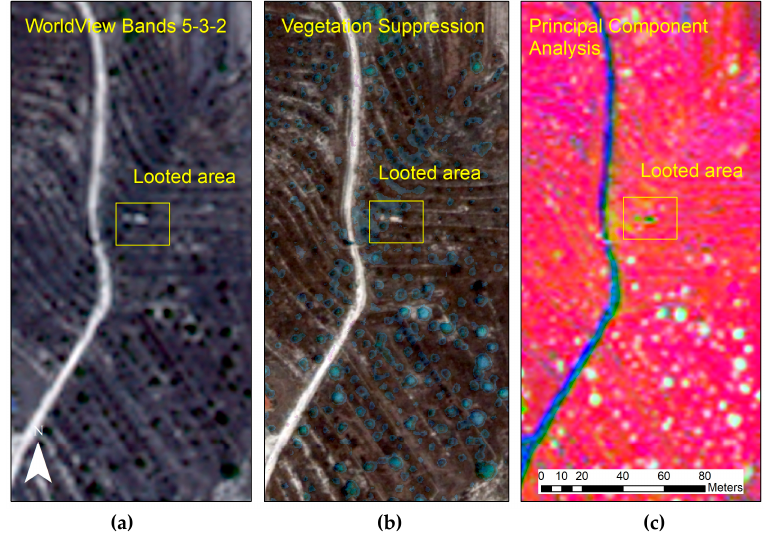
Figure 7. WorldView-2 image 5-3-2 pseudo-color composite ( a ); vegetation suppression result applied at the WorldView-2 image ( b ); and pseudo-color composite of the first three principal components (PC1–PC3) of the WorldView-2 image ( c ). The looted tomb is identified by the yellow square.